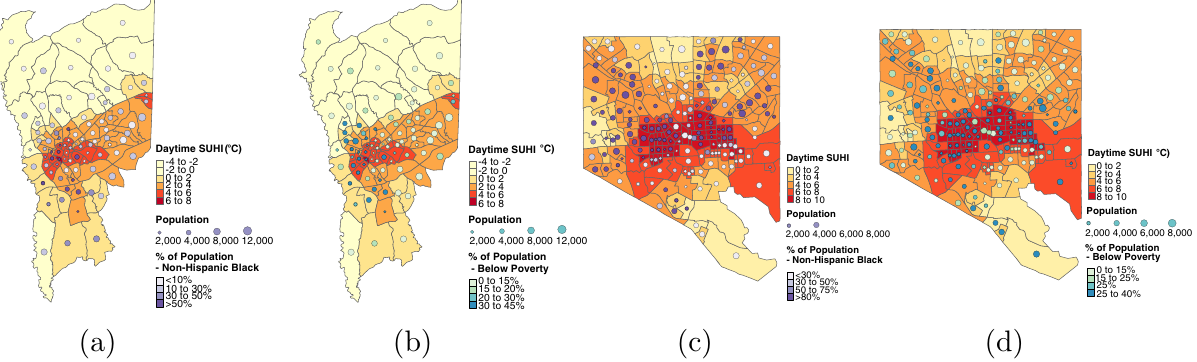
Fig. 3 Distribution of surface urban heat island intensity (SUHI) by race and income in Greenville, SC, and Baltimore, MD. The correlation between SUHI intensity (dark orange and red) and census tracts that are predominantly non-Hispanic Black (in dark purple) and low-income areas (in dark teal) differs across cities. Hispanic is de fi ned as all who report “ Hispanic, Latino, or Spanish origin ” as their ethnicity, regardless of race. a Greenville, SC: SUHI and race. b Greenville, SC: SUHI and income. c Baltimore, MD: SUHI and race. d Baltimore, MD: SUHI and